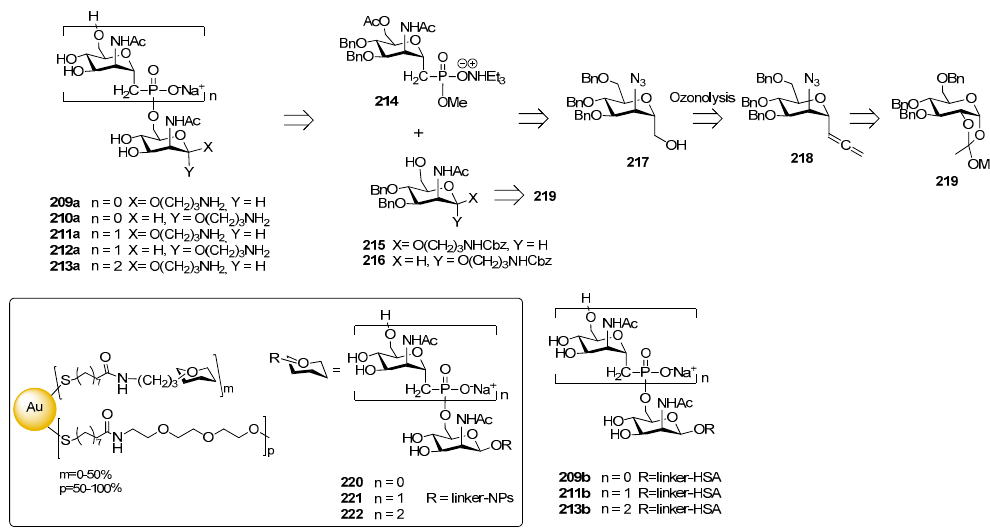
Figure 24. Retrosynthetic strategy for the synthesis of C-phosphono analogues of MenA CPS reported in [174] and multivalent presentation of the fragments [181].